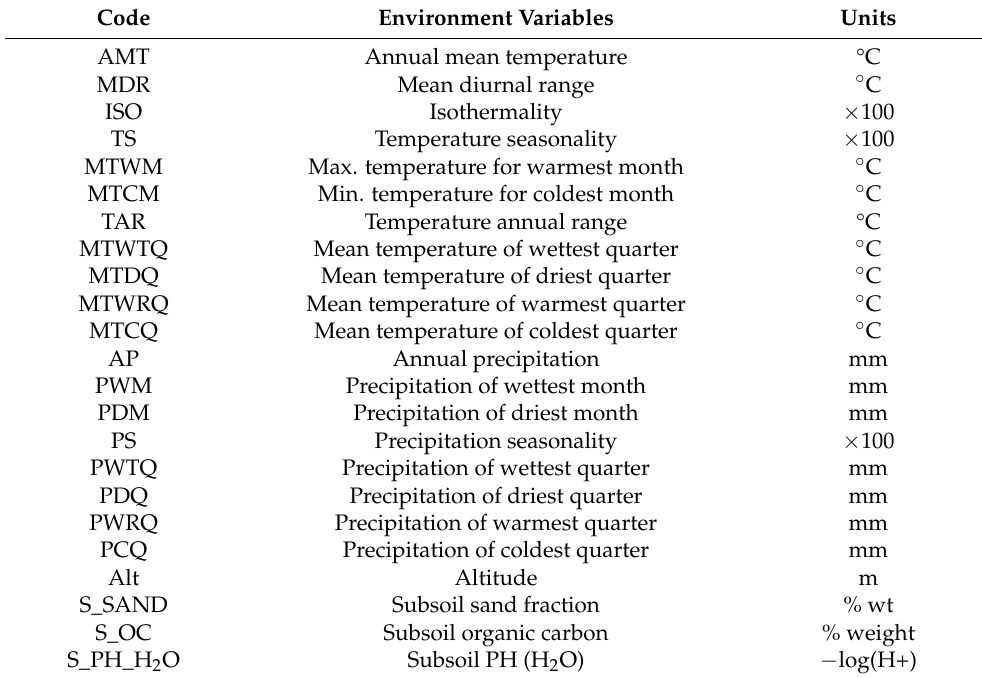
Table 2. Environmental variables used in the potential distribution modeling of Pyrus